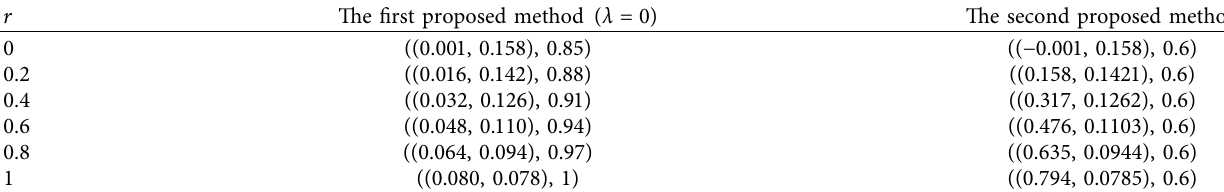
( r ) result using the two proposed methods ( λ � 0 ) 5